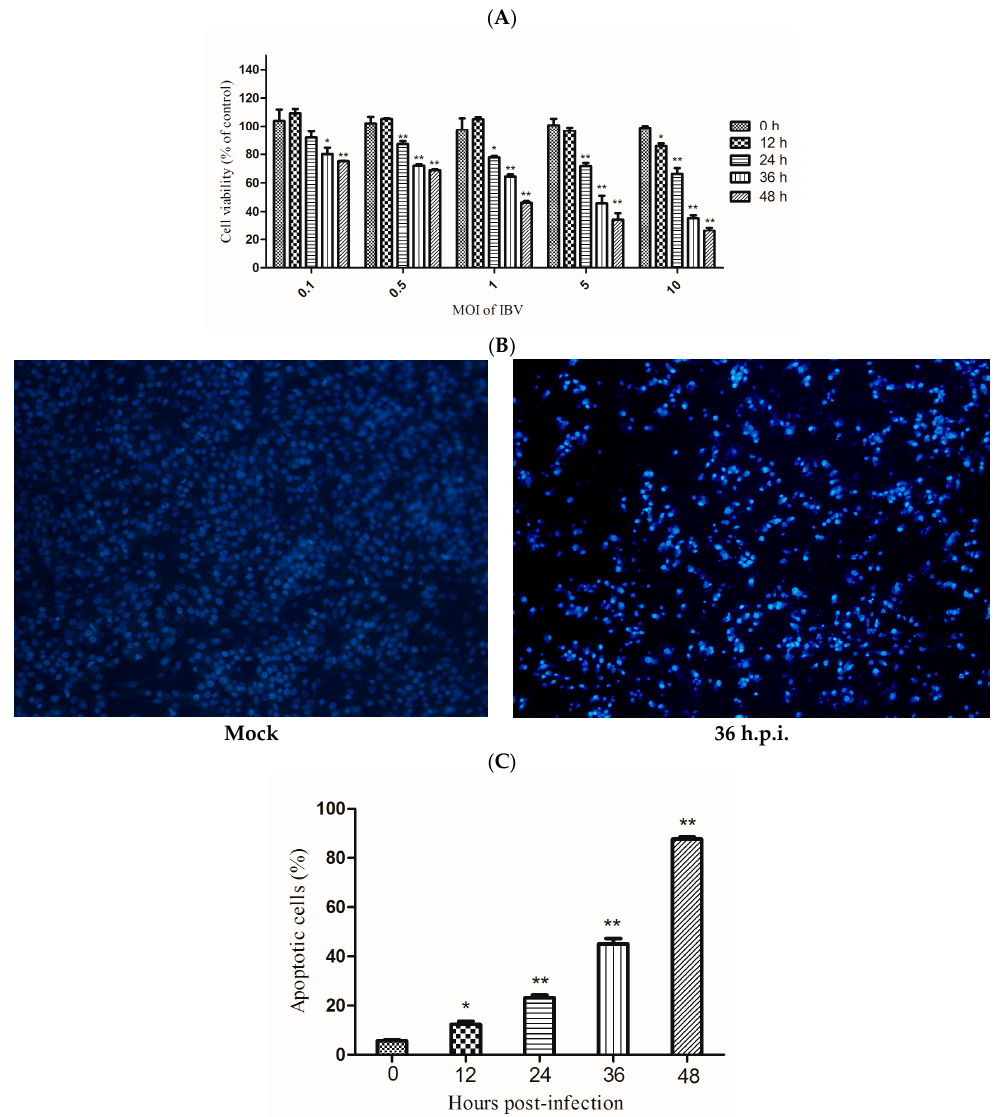
Figure 2. IBV Beaudette induces apoptosis in HD11 cells. ( A ) The role of IBV Beaudette in cell viability. HD11 cells were infected with IBV Beaudette at different MOIs and detected at the indicated times. The Cell Counting Kit-8 (CCK-8) assay was used to measure cell viability. The data are shown as the mean ± SEM of three independent experiments. * p < 0.05, ** p < 0.01 versus control group (0 h). ( B ) Morphological changes. IBV Beaudette-infected cells were observed with condensed chromatin and nuclear fragmentation under fluorescence microscopy followed by Hoechst 33342 staining. ( C ) The apoptotic rate of cells. IBV Beaudette-infected cells (10 MOI) were subjected to flow cytometry at different times. Data are shown as the mean ± SEM of three independent experiments. * p < 0.05, ** p < 0.01 versus control group (0 h).